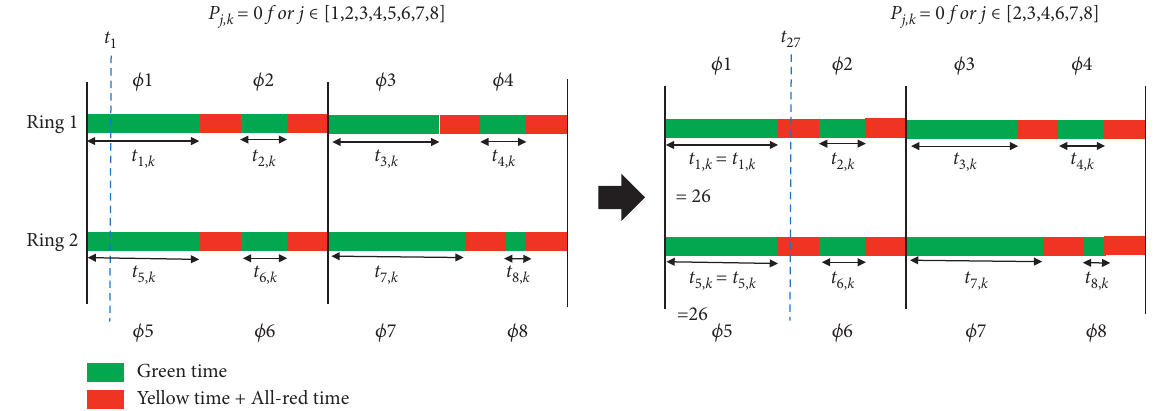
Figure 4: Example of green time equal